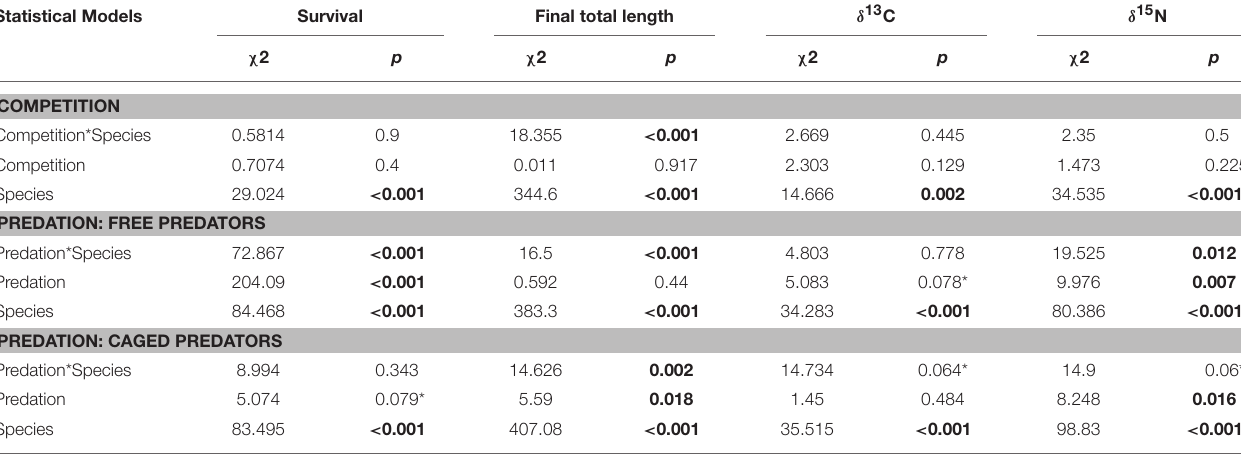
TABLE 1 | Community responses (for survival, final total length and stable isotopes) to competition and predation. Statistical Models